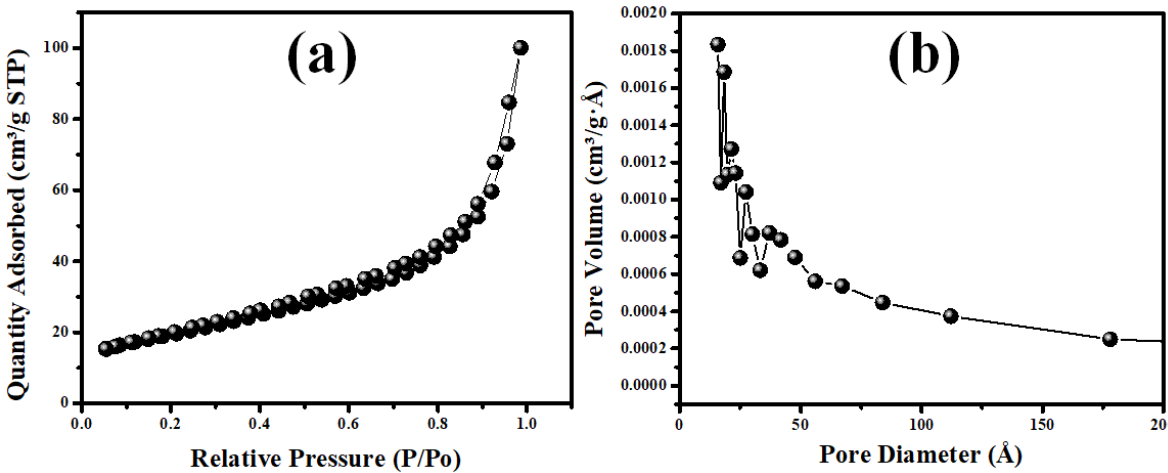
Figure 4. ( a ) BET surface isotherms and ( b ) pore sizes distribution of the CaO-g-C 3 N 4